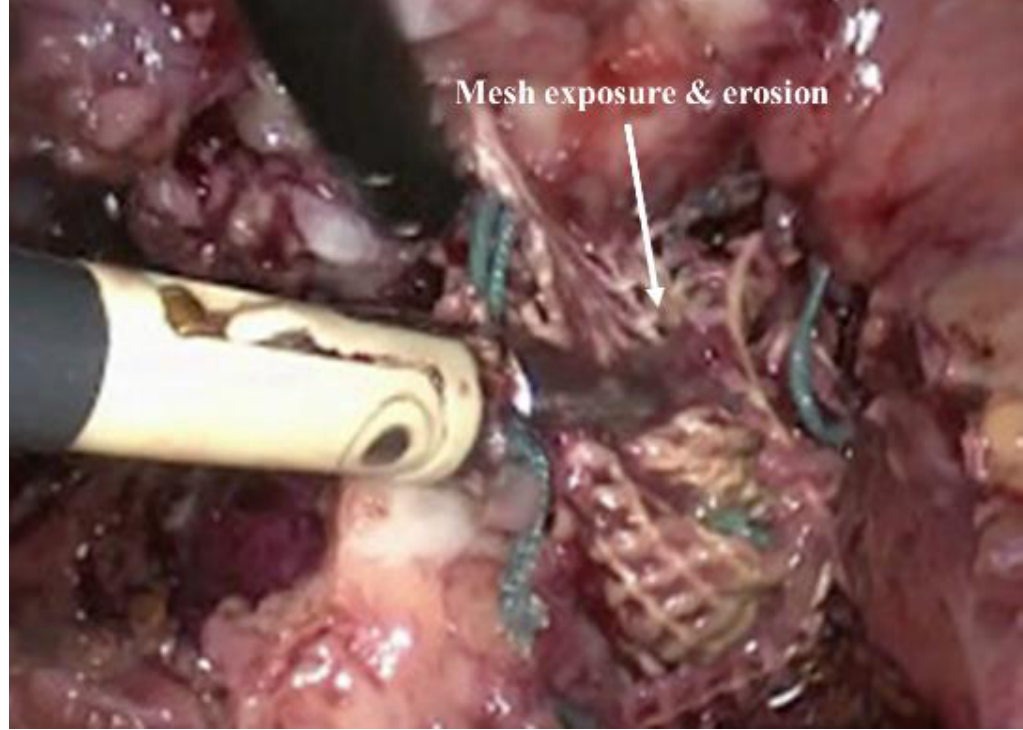
Figure 3. Mesh exposure and erosion of using non degradable meshes in POP surgery. Reproduced with permission of [39]. Copyright AAGL,